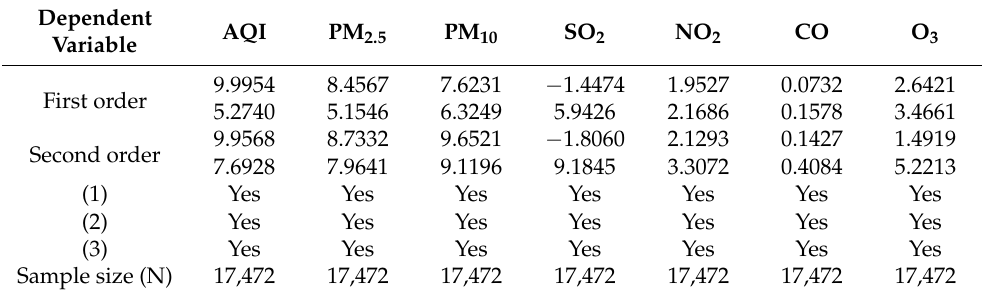
Table 8. Results of RD estimation of daily frequency in heating vs. non-heating cities. Dependent